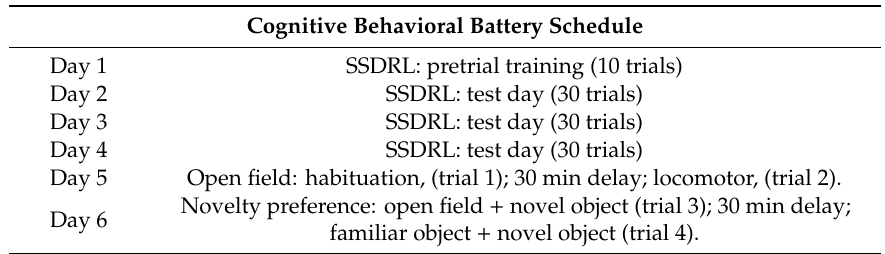
Table 1. Cognitive behavioral assessment schedule. SSDRL, Serial Spatial Discrimination Reversal